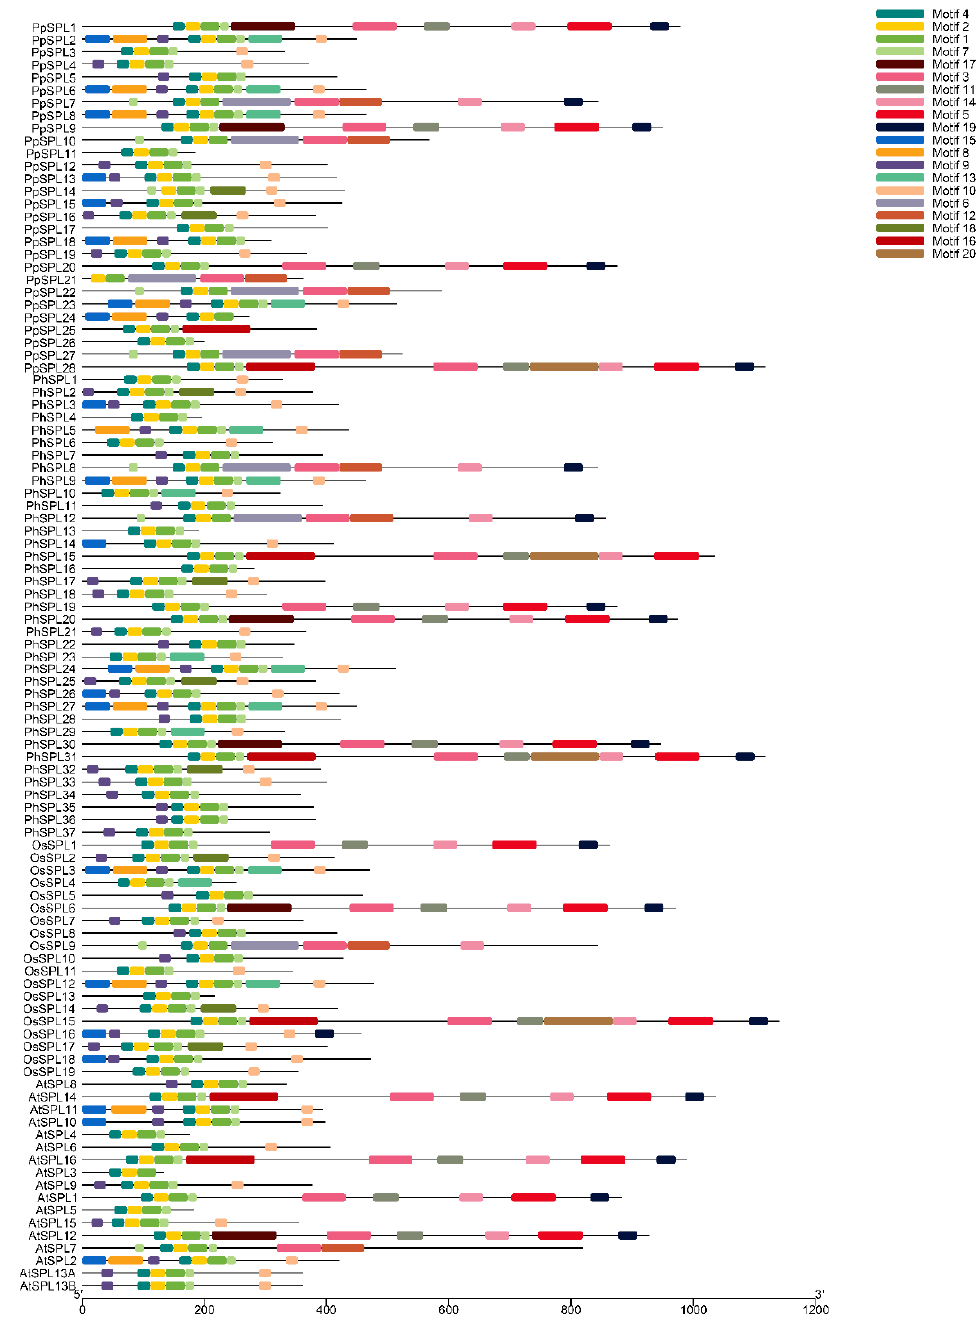
Figure 3. Motif distribution of SPL genes from Arabidopsis thaliana , Oryza sativa , Phyllostachys edulis , and Pleioblastus pygmaeus . AtSPLs , the SPLs from Arabidopsis thaliana ; OsSLPs , the SPLs from Oryza sativa ; PhSLPs , the SPLs from Phyllostachys edulis ; PpSLPs , the SPLs from Pleioblastus pygmaeus .